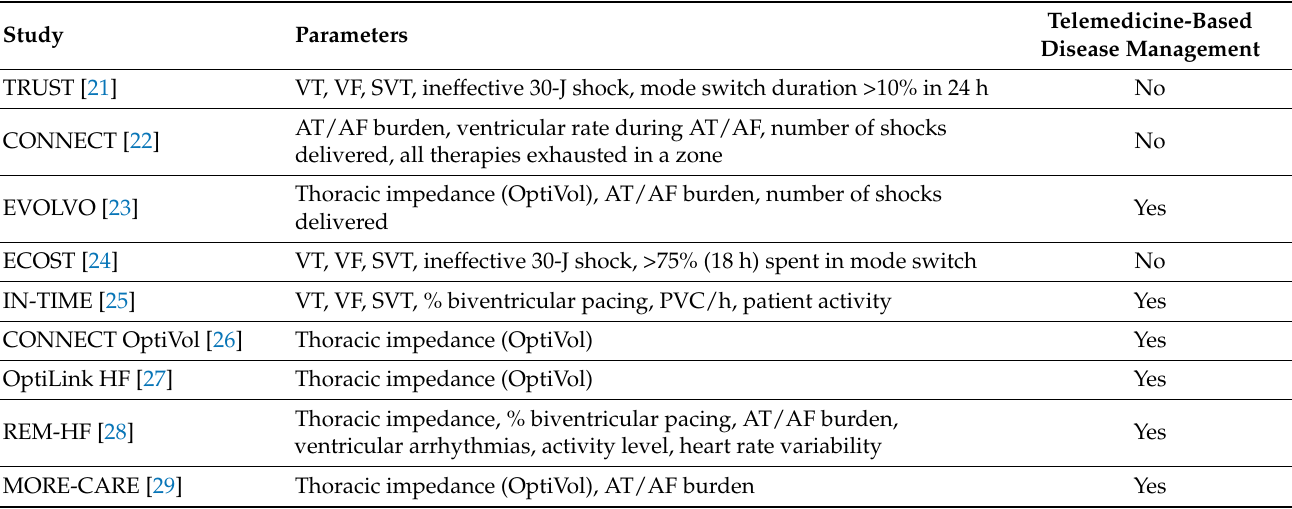
Table 2. Overview of programmed clinical parameters in the randomized clinical